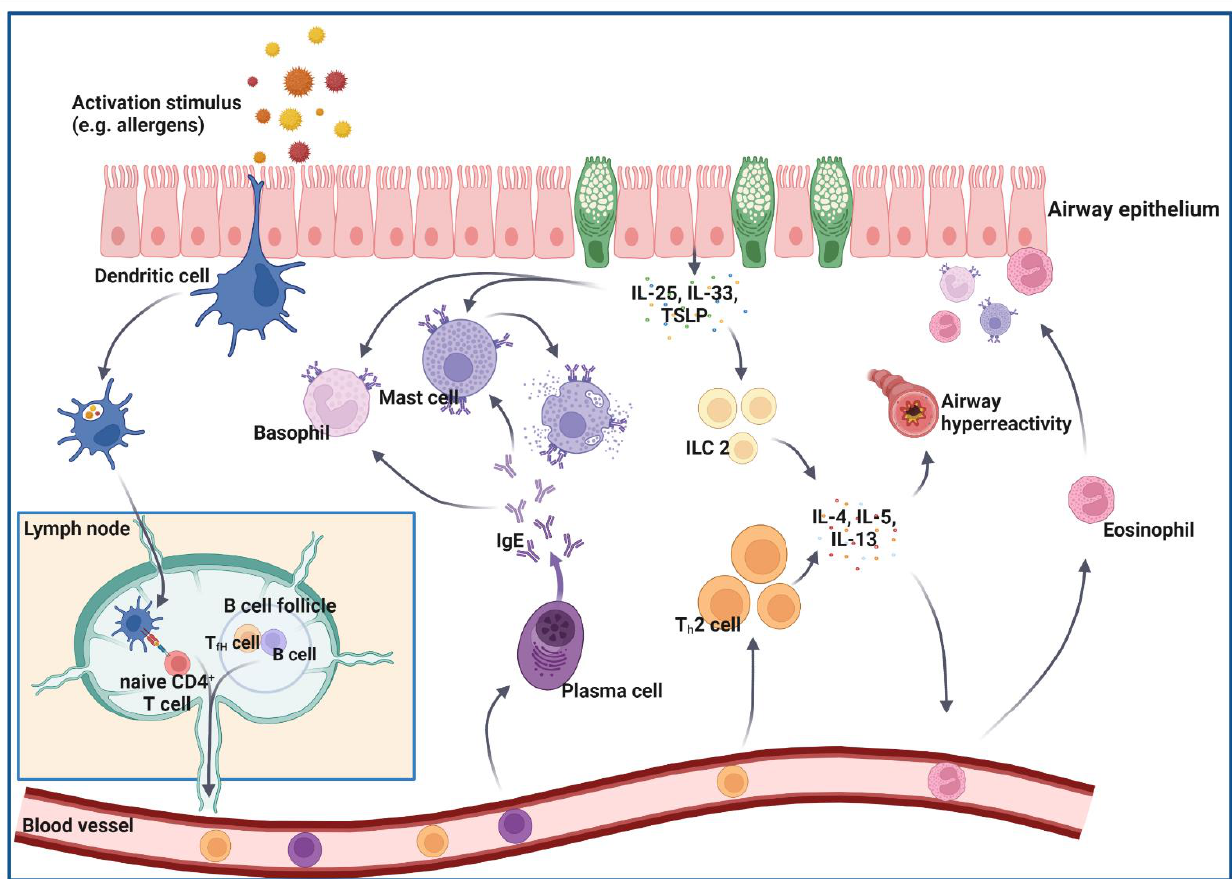
Figure 1 . Key effector cells and soluble mediators in the pathogenesis of allergic asthma. After detection, internalization, and processing by dendritic cells, peptide fragments of the allergen are presented via MHII to naïve CD4 + T cells. These become activated, differentiate into Th2 cells, and produce huge amounts of typical type 2 cytokines, such as IL-4, IL-5, and IL-13. IL-4 and IL-13 promote class switching in B cells into IgE-producing plasma cells. Allergen-specific IgE antibodies bind to specific Fcε -receptors on the surfaces of basophils and mast cells. Following prior sensitization against a specific allergen, the respiratory tract is re-challenged with the allergen and allergen-specific Th2 cells are activated. Due to the cross-linking of membrane-bound, allergen-specific IgE antibodies by the allergen, the degranulation of basophils and mast cells is triggered, and mediators such as histamines or leukotrienes are released, further enhancing the allergic reaction. Blood eosinophils are recruited to the airway epithelium due to, amongst other chemoattractants, increased IL-5 concentrations. In addition to their barrier function, airway epithelial cells are able to produce a variety of cytokines, such as IL-25, IL-33 and thymic lymphopoeitin (TSLP), which further enhance the allergic reaction via the activation of basophils, mast cells, and innate lymphoid cells type 2 (ILC2). References are in the main text. Created with BioRender.com.